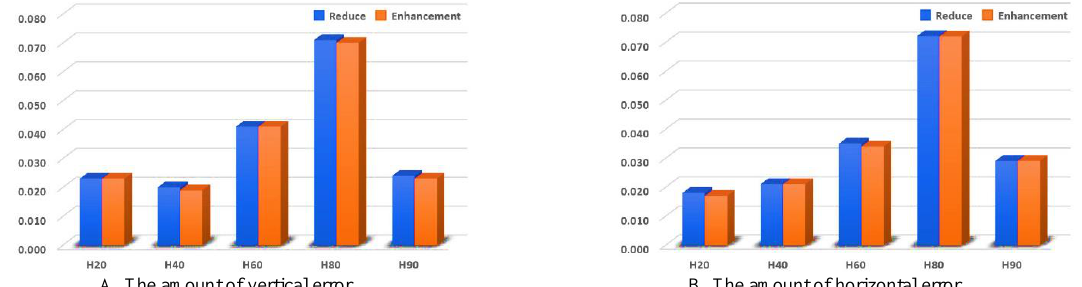
Figure 8 . Diagram depicting the amount of error obtained on the check points at five different flight altitudes and two modes (low contrast and enhanced